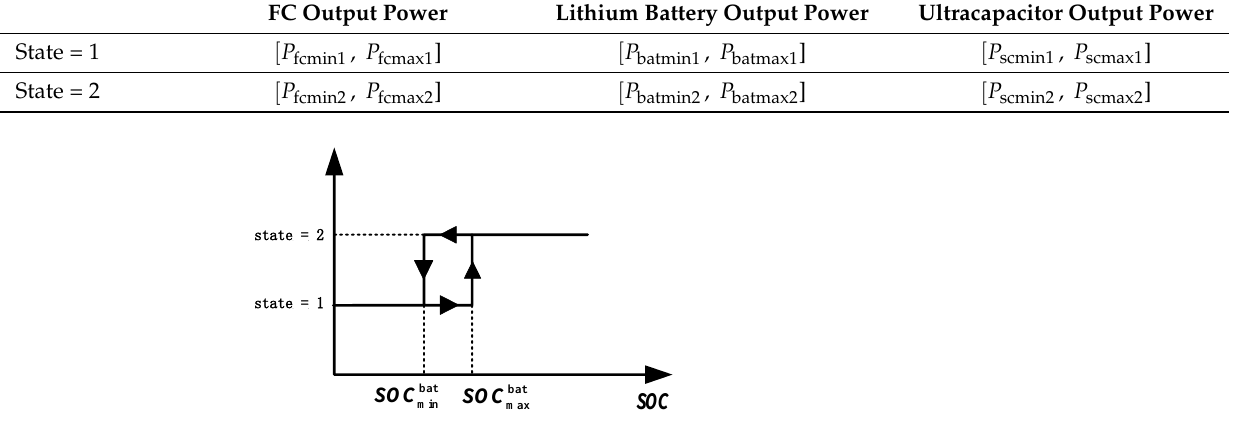
Figure 12. Upper and lower output power switching diagram for each power generation device.